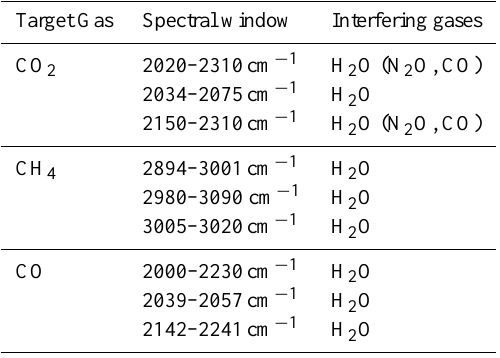
Table 2. Spectral windows used here for the retrieval of CO 2 , CH 4 and CO and marked in Fig. 4. Also listed are the potentially interfer- ing gases (those in brackets were not included in the forward-model spectral simulation conducted here due to the very short clean air atmosphere path used, but would generally be required over longer pathlengths in the ambient